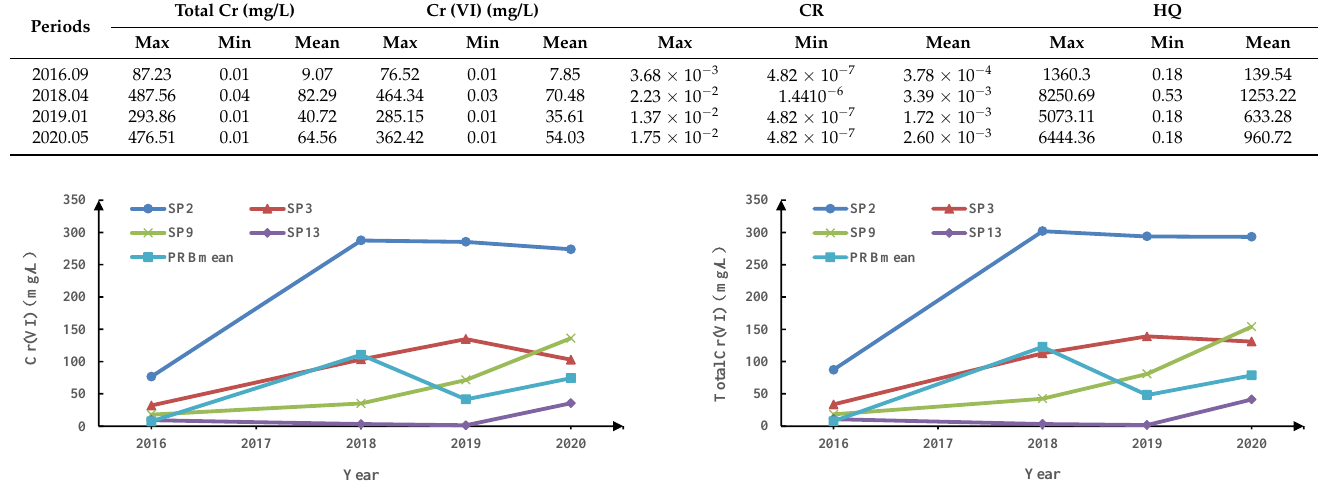
Figure 2. Cr(VI) and total Cr concentrations at typical sampling points and PRB regional means. The average Cr(VI) concentration in groundwater samples from the research area was 41.99 mg/L, ranging from 0.01 to 464.34 mg/L. The majority of the groundwater samples showed Cr values substantially over the World Health Organization (WHO) drinking water quality threshold, which is 50 µ g/L [46]. The study area has a high level of groundwater exploitation, and the survey discovered 39 wells within 2 km 2 of the Cr open dump site, which are primarily used to irrigate agricultural land. Due to insufficient anti-seepage methods of shallow agricultural irrigation wells in the early years, the short depth of